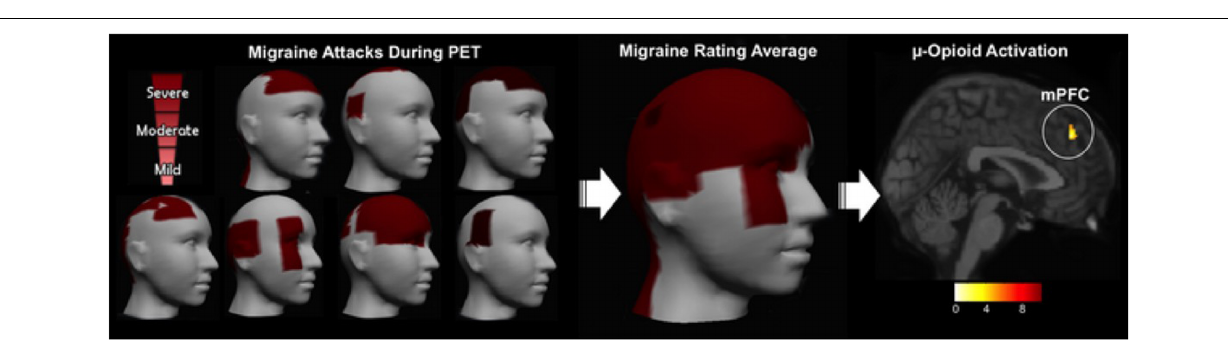
FIGURE 3 | Migraine severity and ictal µ -opioid activation. (Left) Pain intensity and location in each migraine patient evaluated. (Center) 3D image representing the average rating of both the pain intensity and the pain location. (Right) Decreased µ OR BPND in the mPFC during the migraine ictal phase as compared to the interictal phase (DaSilva et al.,